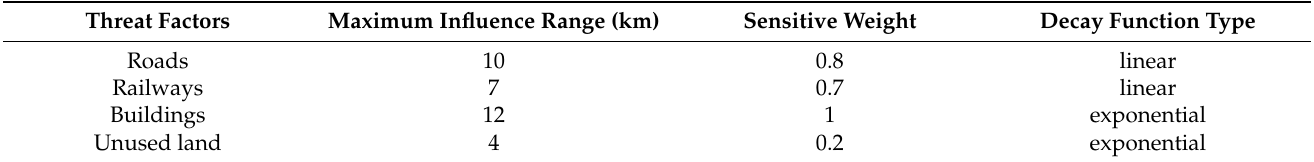
Figure 2. Methodological framework. Table 2. Threat factor weight and influence